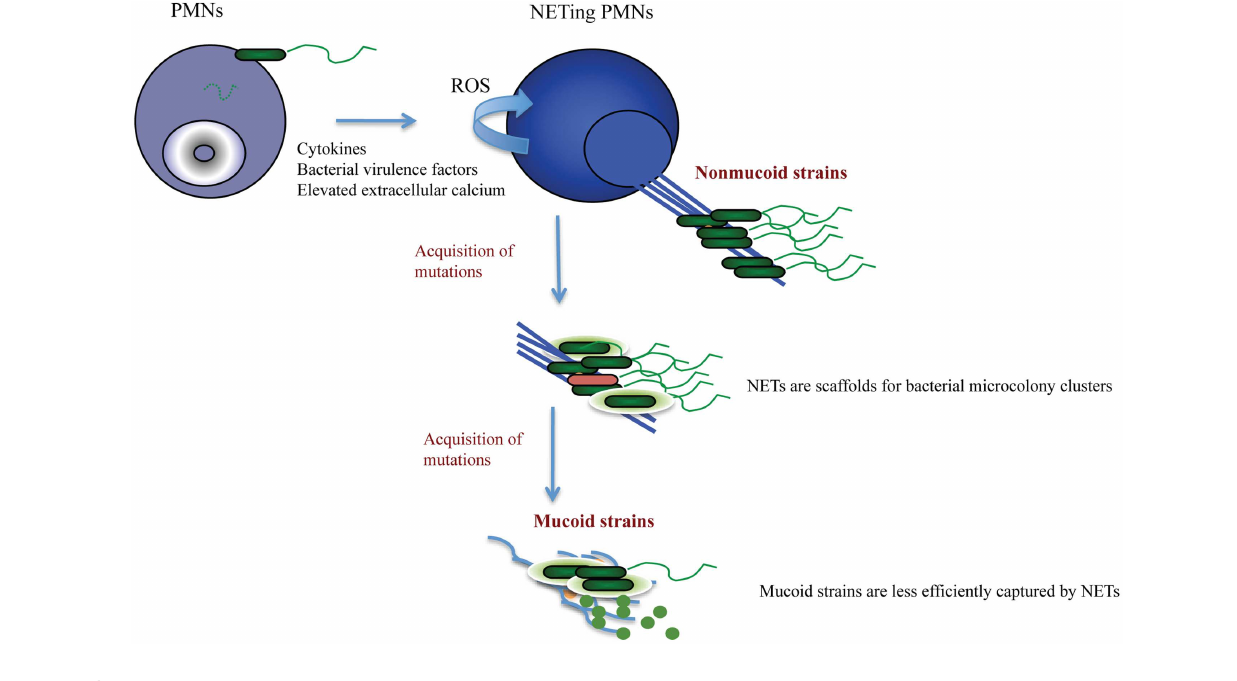
FIGURE 1 | Proposed scenario for NET-triggered P. aeruginosa pathoadaptation . NETosis is stimulated by P. aeruginosa -derived virulence factors released by the non-mucoid “early” strains.The generation of NETs requires activation of NADPH oxidase and ROS production. NETs (blue) provide a scaffold for bacterial attachment and microcolony formation. Albeit sequestering bacteria, NETs fail to successfully kill Pseudomonas sp . Only a few dead bacteria (red) are present within the NET-attached microcolonies.The sublytic